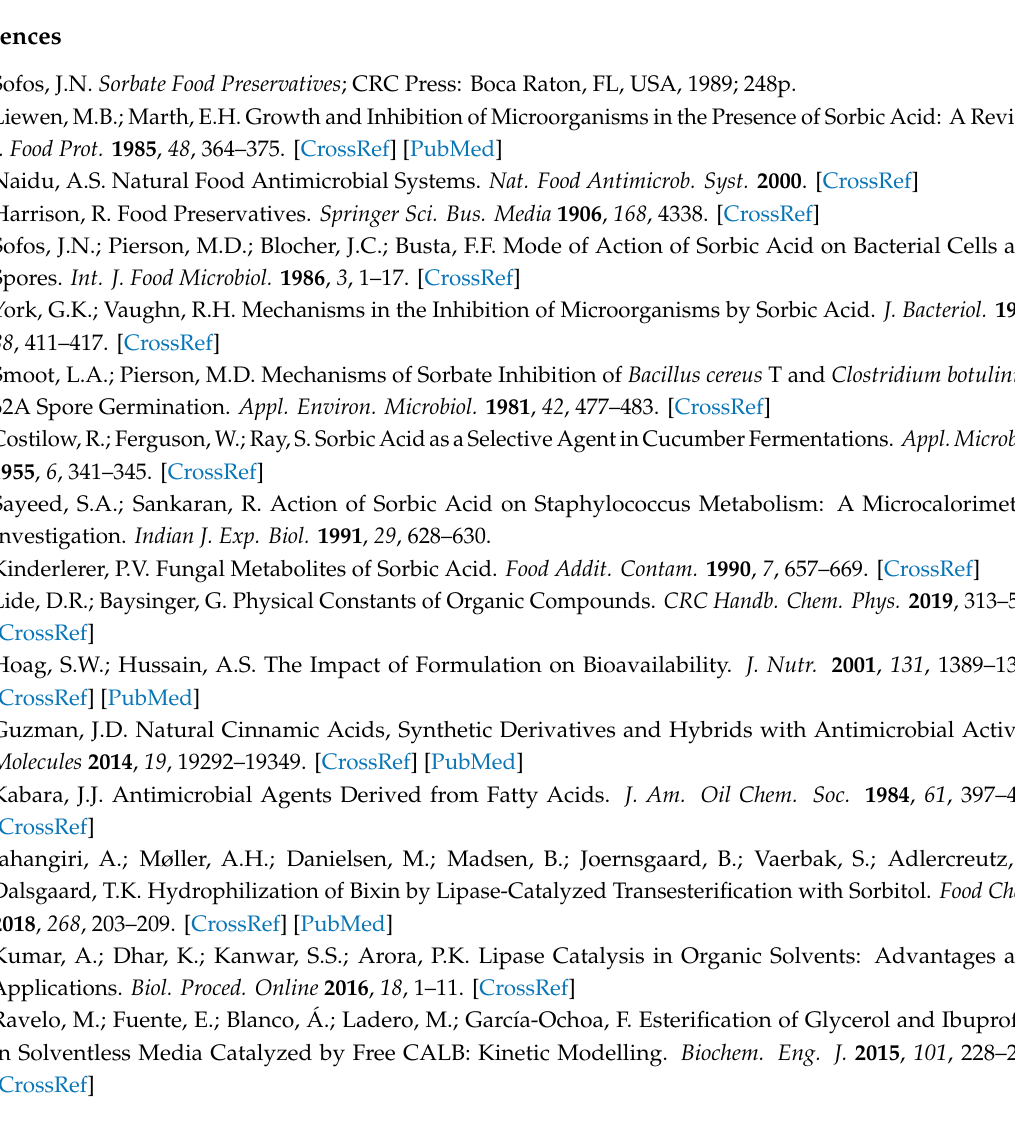
Figure S1: 1 H-NMR spectra of glycerol sorbate, Figure S2: 13 C-NMR of glycerol sorbate; Figure S3: IR spectra of glycerol